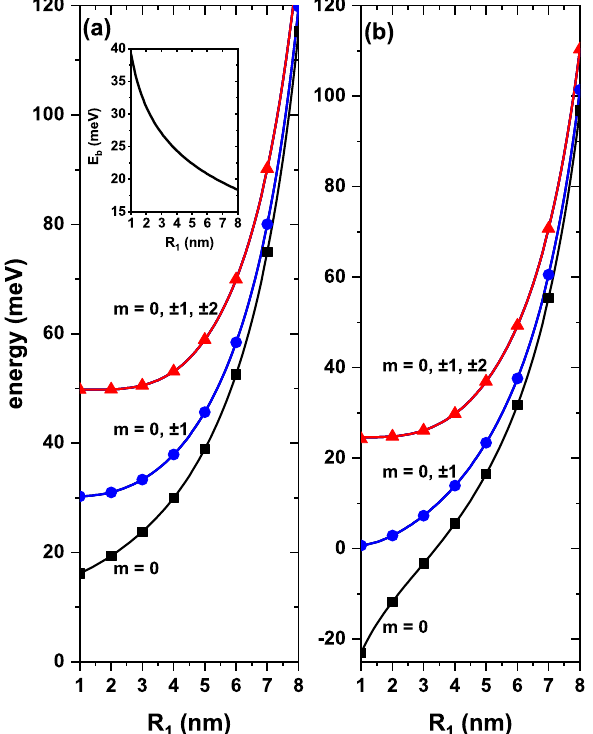
Figure 2. The first three lowest electronic states of a ZnS/CdS/ZnS spherical core/shell/shell quantum dot as functions of the R 1 radius. Figure ( a ) presents the results without, and ( b ) those with effects of an on-center donor impurity, with R 2 = 11nm and R 3 = 12nm, for different values of the m -quantum number and without effects of external electric and magnetic fields. Labels close to the curves indicate the values of the m -quantum number. The inset in Figure ( a ) corresponds to the ground state (lowest state with m = 0) binding energy between the impurity and the electron as a function of the internal dot radius. In both panels, solid symbols correspond to the energies obtained by solving the three-dimensional problem using Equation